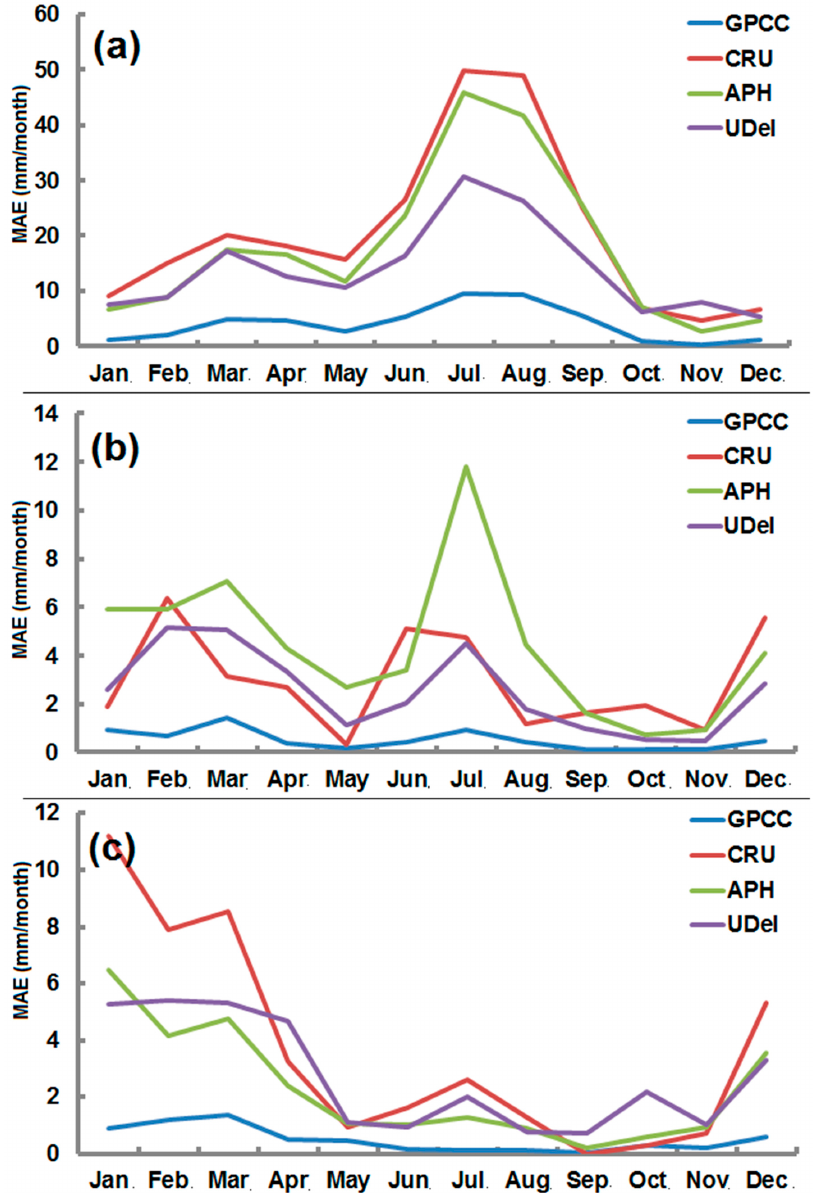
Figure 9. Mean absolute error (MAE) between observed and gauge-based gridded datasets at ( a ) semi-arid, ( b ) arid, and ( c ) hyper-arid station.